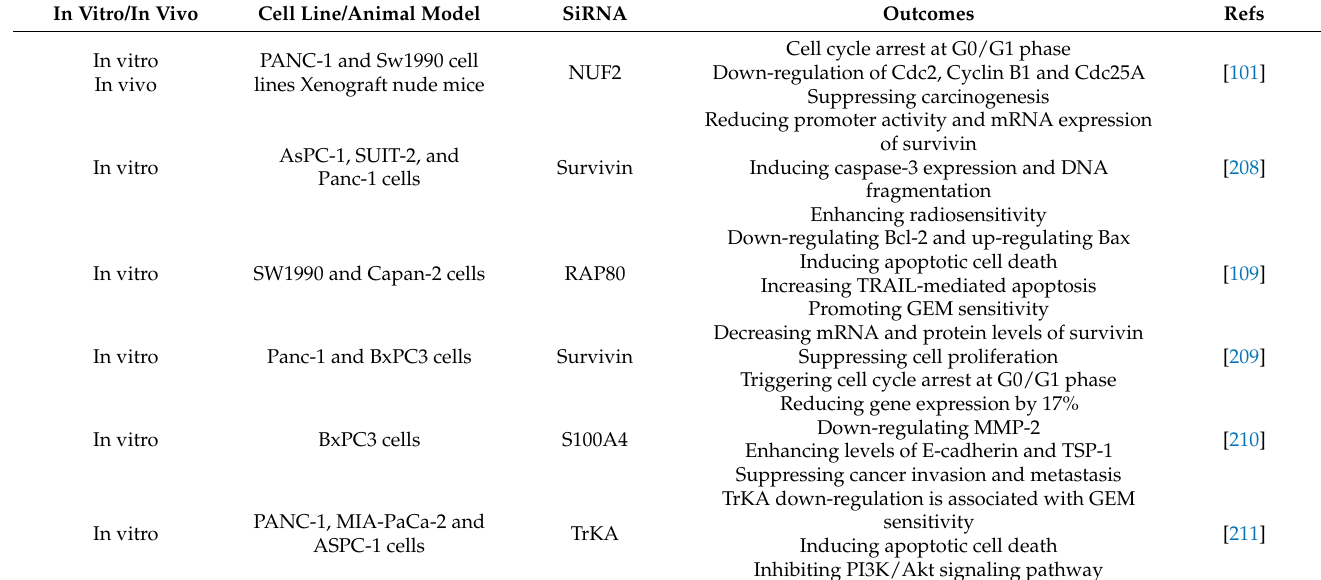
Table 2. Interference with PC progression via application of siRNAs.